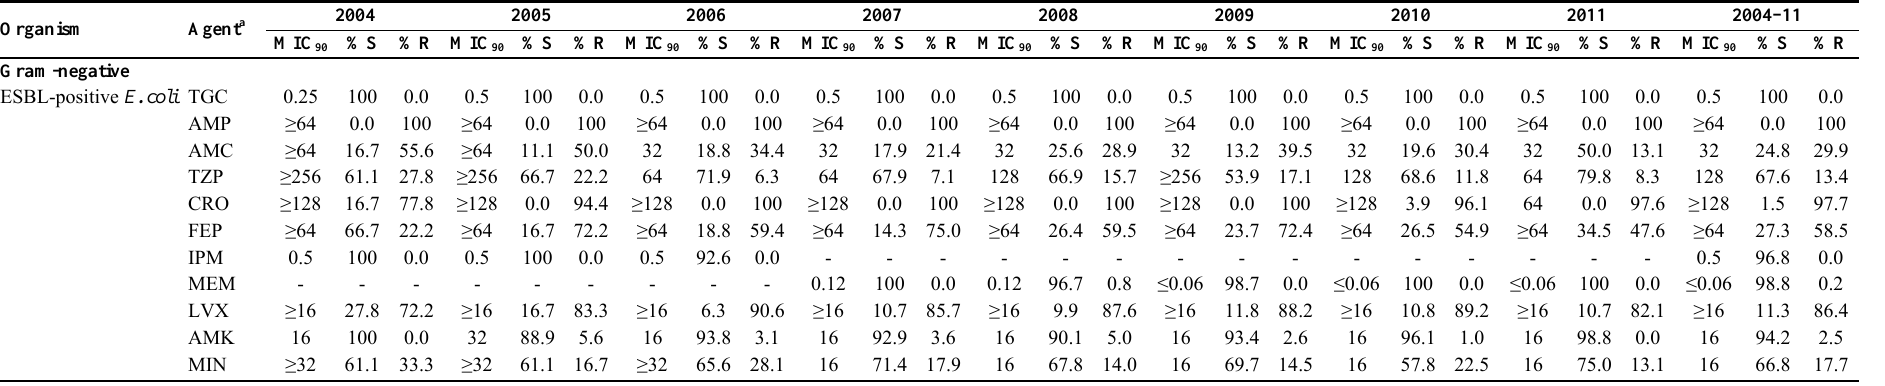
Table 5. Overall prevalence (N) and rate of resistant isolates (n, %) among Gram-negative and Gram-positive isolates collected in Italy during T.E.S.T. 2004–2011. Organism Gram-negative ESBL-producing E. coli β -lactamase-producing H. influenzae ESBL-producing K. oxytoca ESBL-producing K. pneumoniae Gram-positive Vancomycin-resistant E. faecalis Vancomycin-resistant E. faecium Methicillin-resistant S. aureus Penicillin-resistant S. pneumoniae